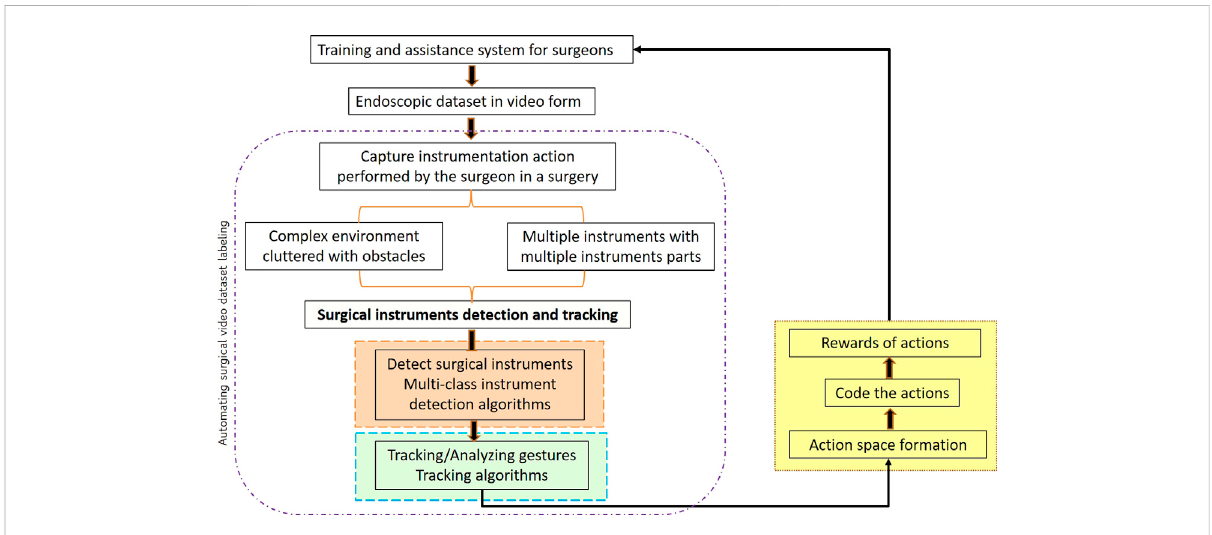
FIGURE 1 Various stages in the surgical skill assessment approach for a training or assistance system (the basis for the categorization of existing